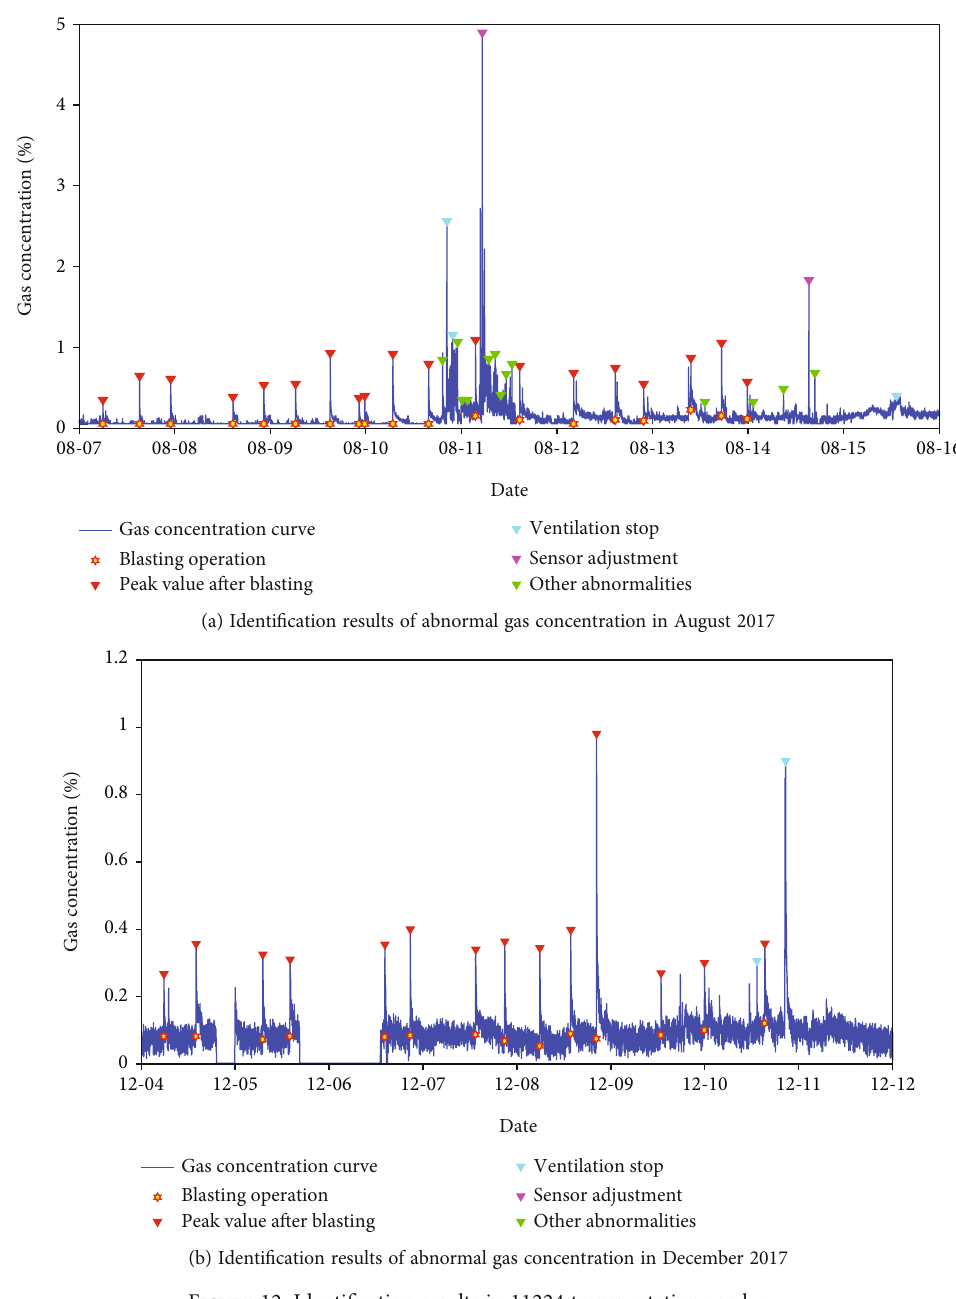
Figure 12: Identi fi cation results in 11224 transportation